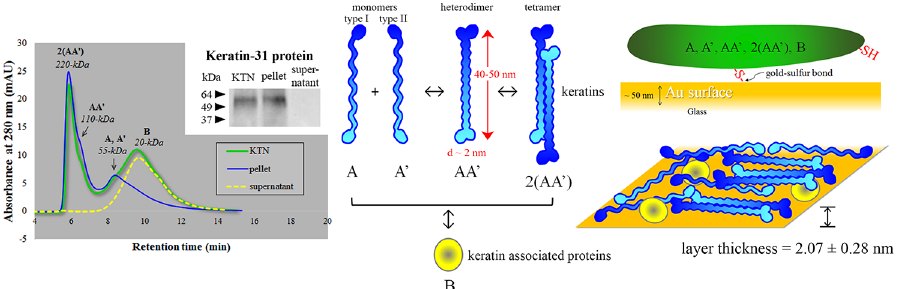
Fig 2. KTN characterization. The KTN extract is comprised of monomeric (A, A ’ ), dimeric (AA ’ ), and tetrameric (2(AA ’ )) keratins as well as keratin associated proteins (B) indicated by peaks corresponding to their respective molecular weights using gel filtration chromatography. One of the protein monomers detected by western blot technique is keratin-31 (K31). Both keratins and keratin associated proteins have free thiols (R-SH) that react with gold and form strong gold-sulfur bonds. Au-S covalent interactions, as well as some physisorption, enable the formation of a stable KTN